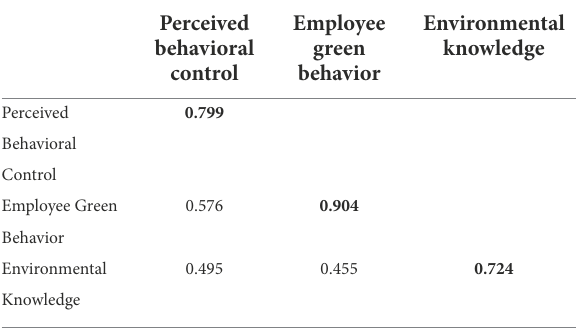
TABLE 3 Fornell and Larcker